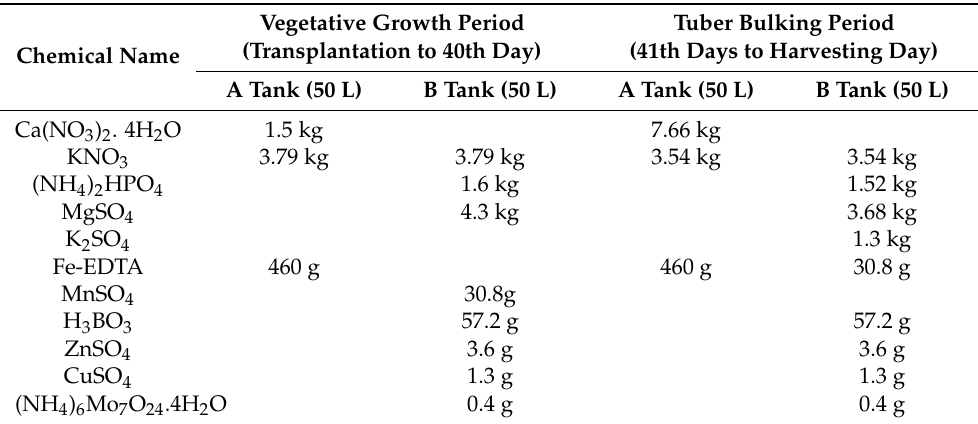
Table 2. Nutrient